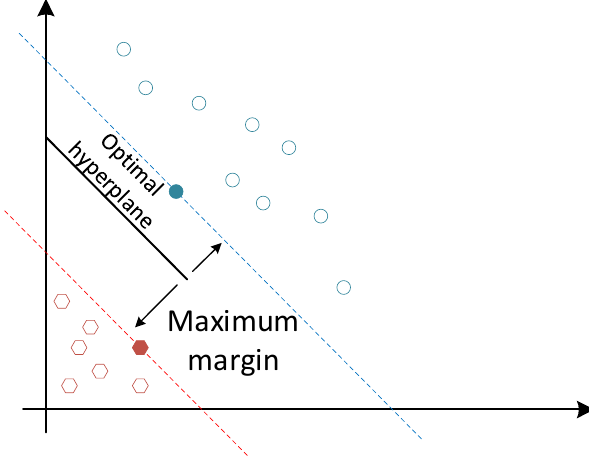
Figure 8. Hyperplane Visualization of SVM classifier.